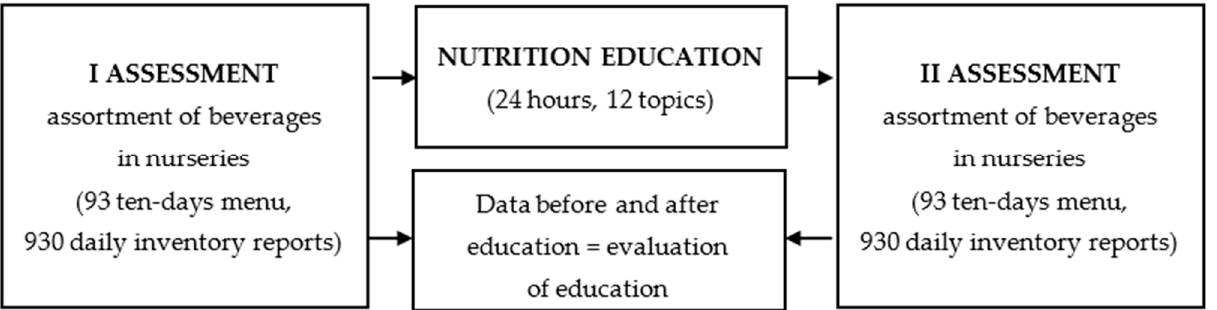
Figure 2. Evaluation of the nutritional education based on analysis of beverages supply in nurseries.